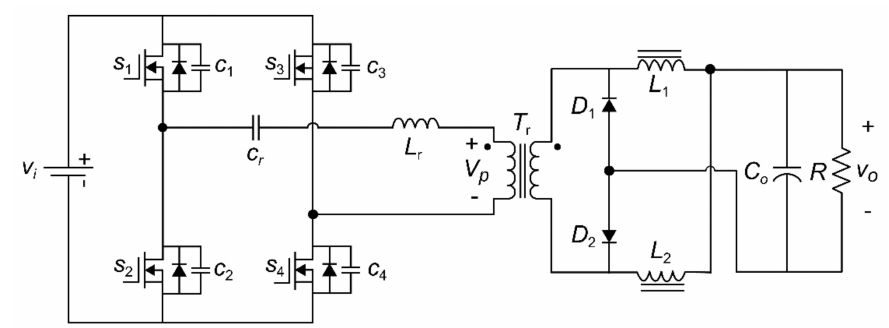
Figure 3. Proposed converter with